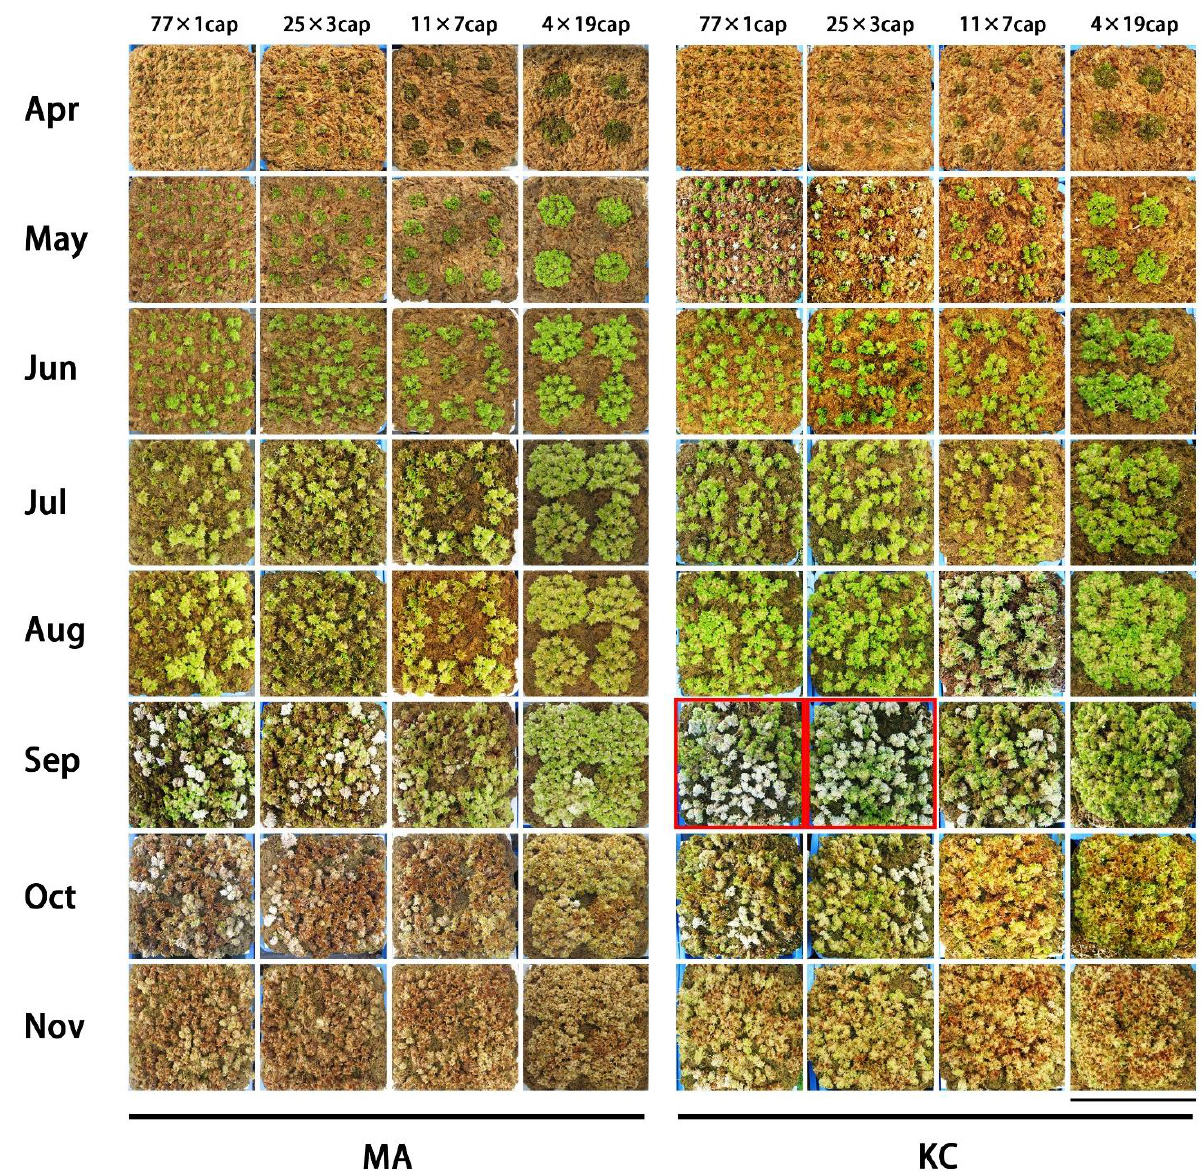
Figure 5. The progress of ‘greening’ of Sphagnum cultures established using the four planting treatments ‘77×1cap’, ‘25×3cap’, ‘11×7cap’ and ‘4×19cap’ at the MA (Mount Aso) and KC (Kumamoto City) experimental sites during the seven-month growing season of 2008. Many capitula in smaller colonies (‘77×1cap’ and ‘25×3cap’) became chlorotic in September, especially at KC (red outlines). Scale bar = 30 cm. ‘25×3cap’, ‘11×7cap’ and ‘4×19cap’ number of side shoots was more than three times the average value for the ‘77×1cap’ planting treatment (Figure 7c). The highest Shpagnum biomass (dry weight) was obtained in the ‘4×19cap’ planting treatment at MA (Figure 7d). Overall, the most stable results for stem elongation and biomass production were obtained in the ‘4×19cap’ planting treatment, with each of four colonies having 19 capitula and quite similar growth at the two experimental sites, although the Sphagnum also grew well in the ‘77×1cap’ and ‘25×3cap’ planting treatments at both